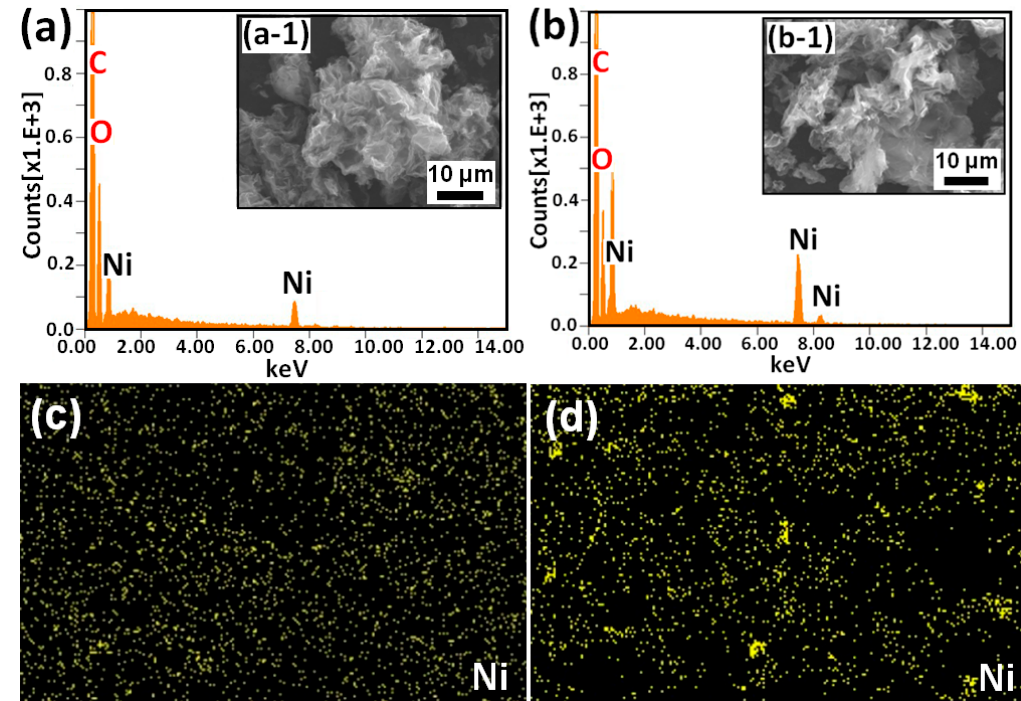
Figure4. SEMimagesandEDSspectraof( a ,( a-1 ))Ni / GO-1and( b ,( b-1 ))Ni / GO-2; andthecorresponding Figure 4 . SEM images and EDS spectra of ( a , a-1 ) Ni/GO-1 and ( b , b-1 ) Ni/GO-2; and the Ni-mapping of ( c ) Ni / GO-1 and ( d ) Ni / corresponding Ni-mapping of ( c ) Ni/GO-1 and ( d ) Ni/GO-2.